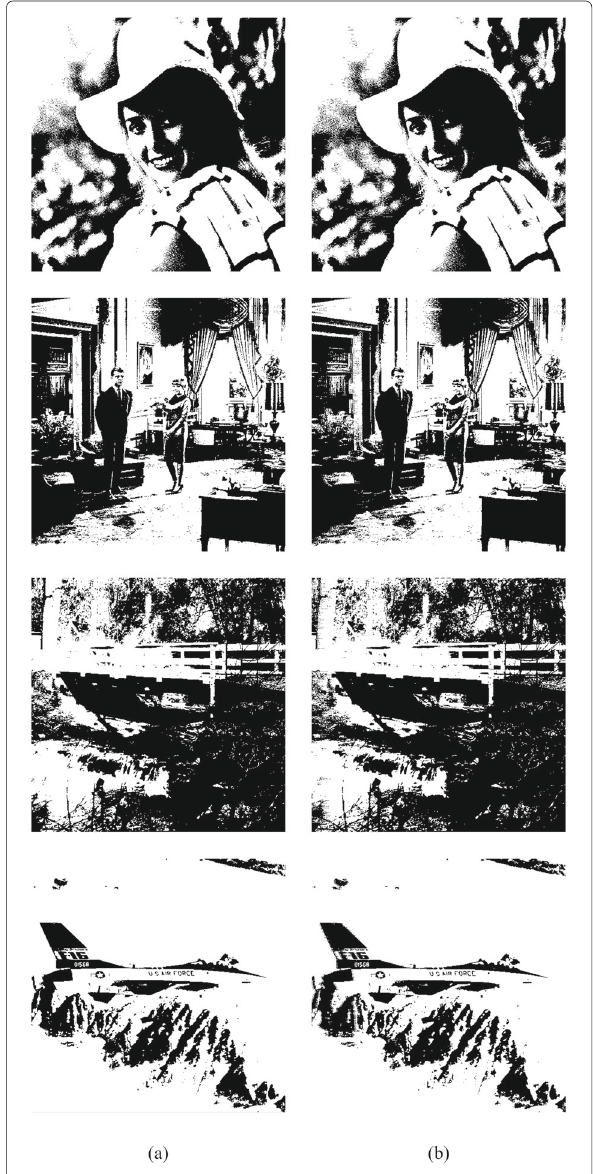
Fig. 11 a The test images. b Images with 1500 bits embedded